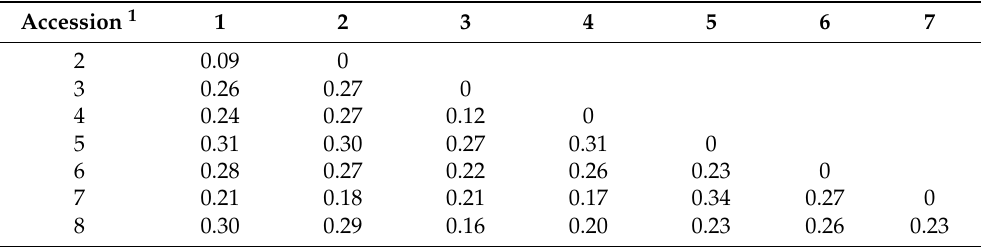
Table 3. Matrix of Nei’s genetic distance coefficients between studied carrot genotypes.